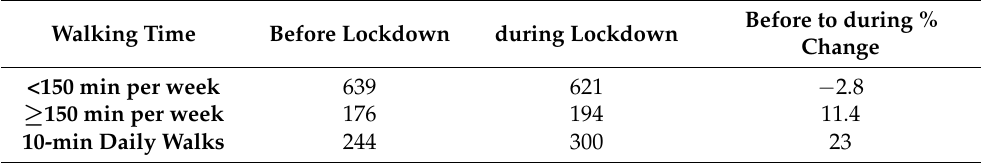
Table 2. Total number of participants and percentage change from before to during lockdown of those completing <150 or ≥ 150 min of moderate-intensity activity per week and walks lasting ≥ 10 min, seven days a